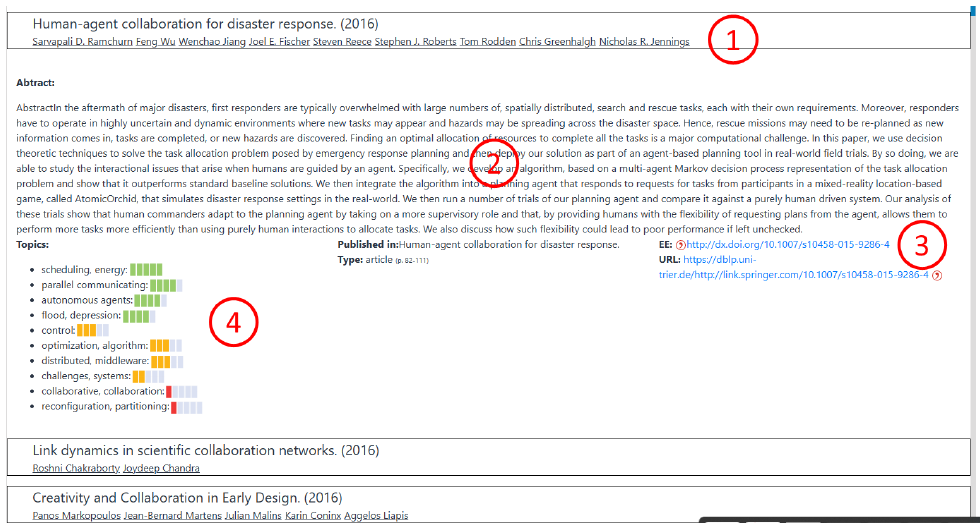
Figure 5. Publication view within the alternative visual analytics view that is based on our previous works [8,28]. (1) shows the title and clickable authors. (2) shows the abstract. (3) shows the DOI. (4) visualizes the previously shown similarity